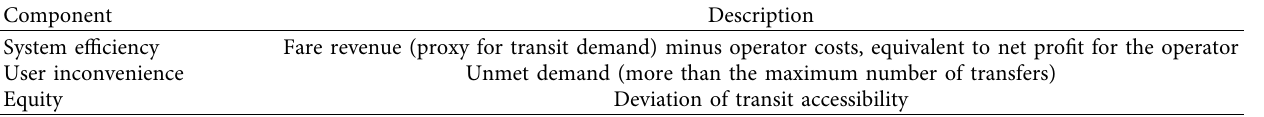
Table 1: Object function components.